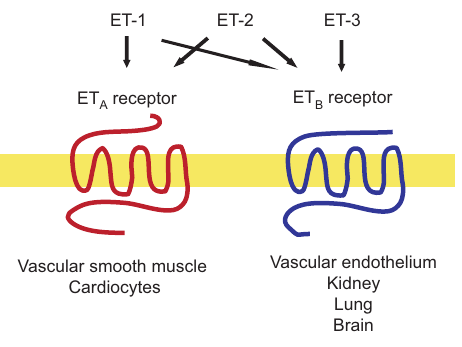
Figure 3 Ligand selectivity of ET receptor